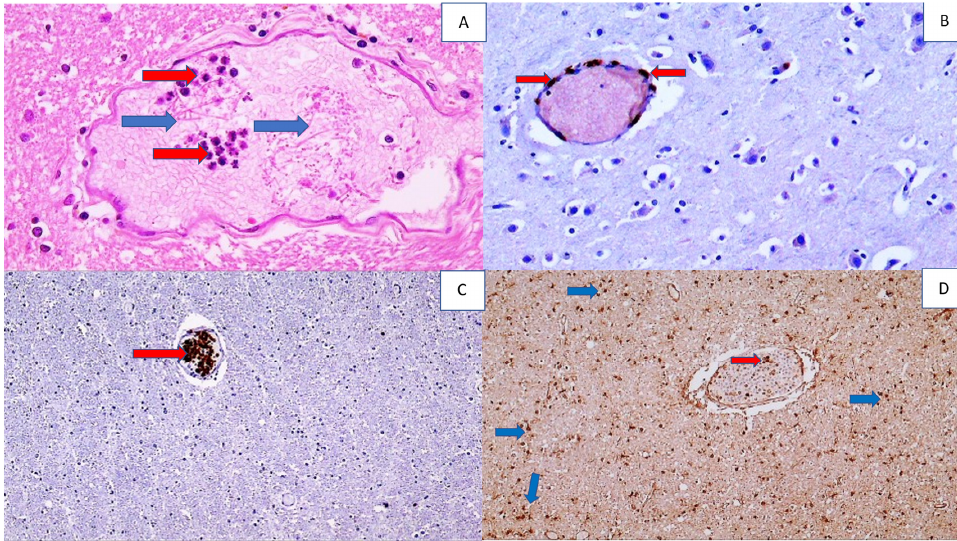
Figure 2. Histology and immunohistochemistry of a brain vessel with fibrin, PMNs, inflammatory T lymphocytes, and reactive astrocytes in the brain of a COVID-19 patient. Photo ( A ) shows a blood vessel in the brain filled with neutrophils (red arrows) and fibrin (blue arrows), (HE, 400×). Photo ( B ) shows a perivascular infiltrate of immunohistochemically CD3-positive T lymphocytes (arrow) in the cerebral vein (DAB, 200×). Photo ( C ) shows immunohistochemically MPO-positive PMNs in a cerebral blood vessel (arrow), (DAB, 100×), while Photo ( D ) shows immunohistochemically SOD2-positive diffuse reactive astrocytes in white matter of the brain (dark brown shows DAB staining; some are indicated by blue arrows) and inflammatory cells in a blood vessel (red arrow) (DAB, 100×).